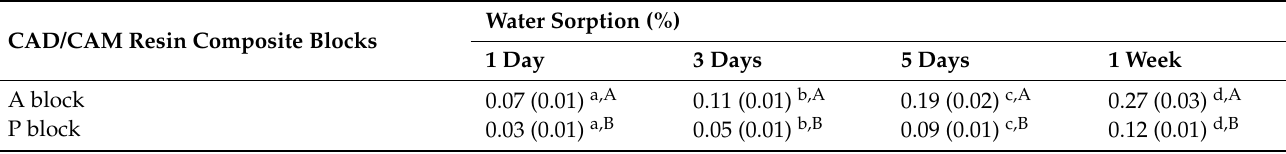
Table 6. Result of water sorption